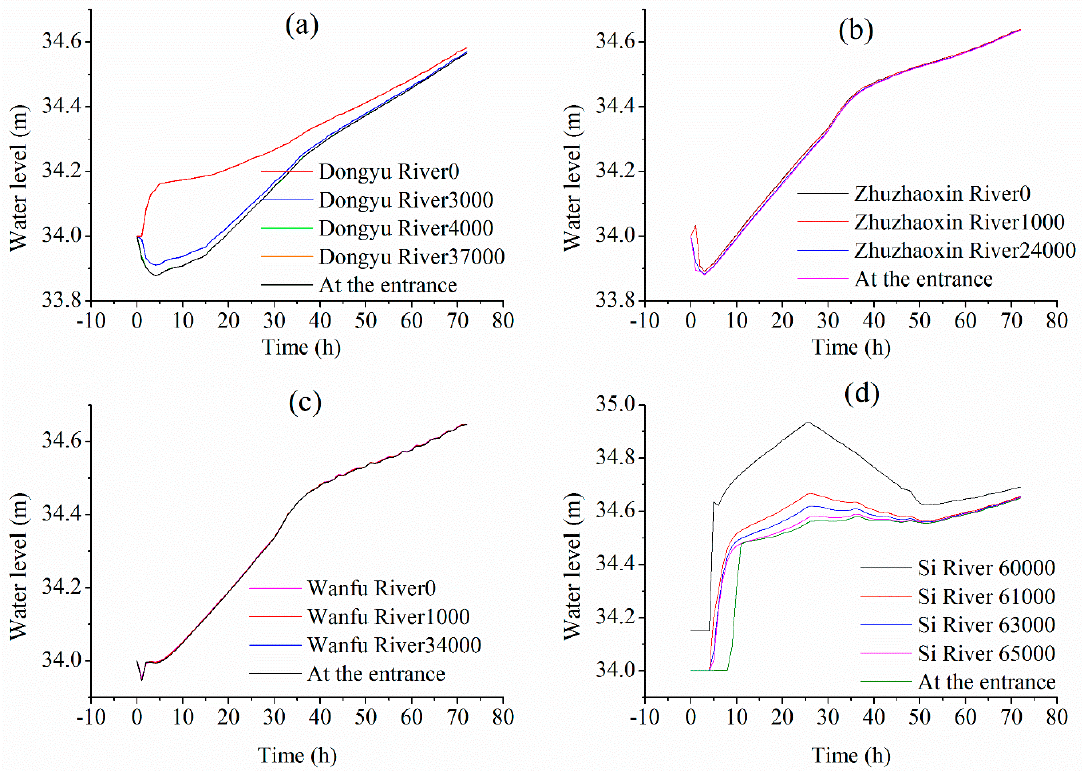
Figure 9. The water levels along different cross-sections of typical rivers entering Nansi Lake. The hydrograph stage at the entrance refers to the lake level at the entrance of each river to Nansi Lake. The numbers denote the distance between this cross-section and its starting point of a river, in which zero refers to the starting point, and the largest number refers to the entrance cross-section. For example, ‘Dongyu River 0’ is the starting point of this river, ‘Dongyu River 37,000’ refers to the entrance cross-section of Dongyu River, and ‘Dongyu River 4000’ indicates that this cross-section is 4000 meters away from the starting point and 33,000 meters away from the entrance cross-section.